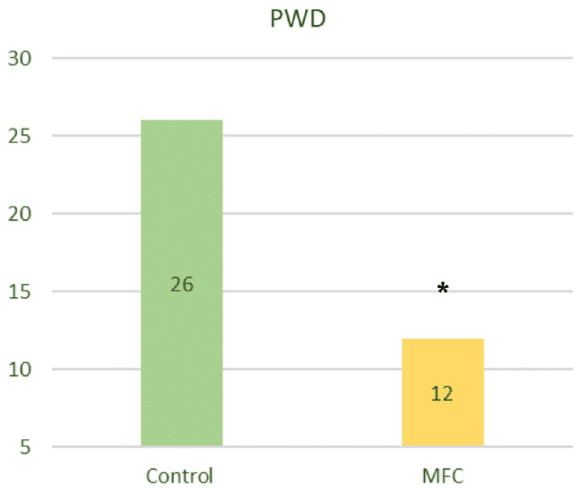
Figure 2. Piglet diarrhea cases at 7 weeks of age (PWD). Asterisks indicate the statistically significant differences (p < 0.05).